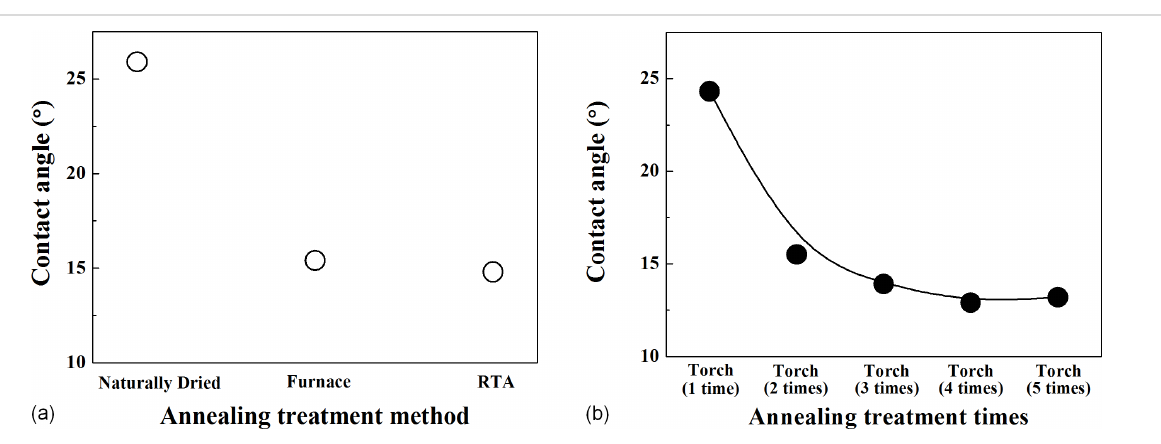
Figure 3: Contact angle by (a) annealing treatment method and (b) annealing treatment times using a gas